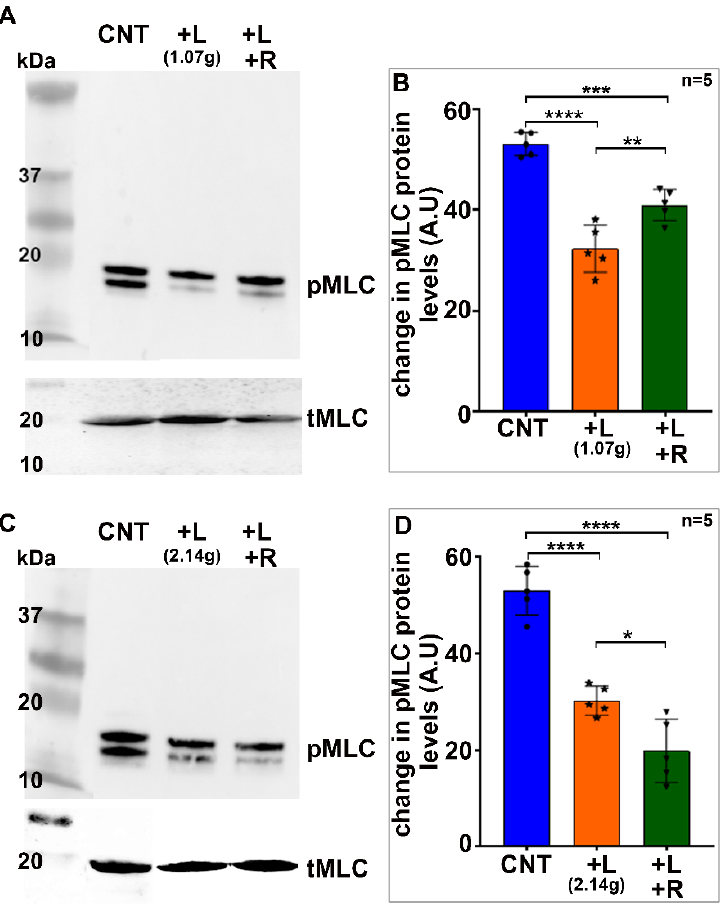
Figure 2. Load-induced lens deformation using glass coverslips decreases myosin II activity. For this, either 5 (total weight = 1.07 g) or 10 (total weight = 2.14 g) glass coverslips were stacked on 2 different sets of mouse lenses (from 4-week-old mice) for 60 s. Following lens compression, half of the total lenses from each set were immediately treated with TCA, while the other half were treated with TCA sixty seconds after the glass coverslips were removed, to determine the levels of phospho-MLC and total MLC. The lens-compression-induced use of glass coverslips for 60 s ( A , B , 5 coverslips; C , D , 10 coverslips) was associated with an obvious decrease (ranging from 35–45%) in the levels of phospho-MLC compared to the control lenses ( n = 5). There was a slight but significant increase (~25%) in the levels of phospho-MLC upon removal of the glass coverslips during the 60 s resilience period in the lens group loaded with 5 coverslips ( B ). Overall, however, there was still a marked decrease in the levels of phospho-MLC (by >20 and 60%, for 5- and 10-coverslip-loaded lenses, respectively) in compressed lenses allowed to ‘recover’ for 60 s after the removal of glass coverslips relative to the control lenses. Total MLC levels were not different between the compressed and uncompressed (control) lenses ( A , C ). Cnt: Control; L: Lenses loaded with glass coverslips for 60 s; L + R: Lenses loaded with coverslips for 60 s and allowed to ‘recover’ for 60 s prior to analysis. Values are presented as Mean ± SEM. * p < 0.5; ** p < 0.01; *** p < 0.001; **** p < 0.0001. A.U.: Arbitrary Unites.